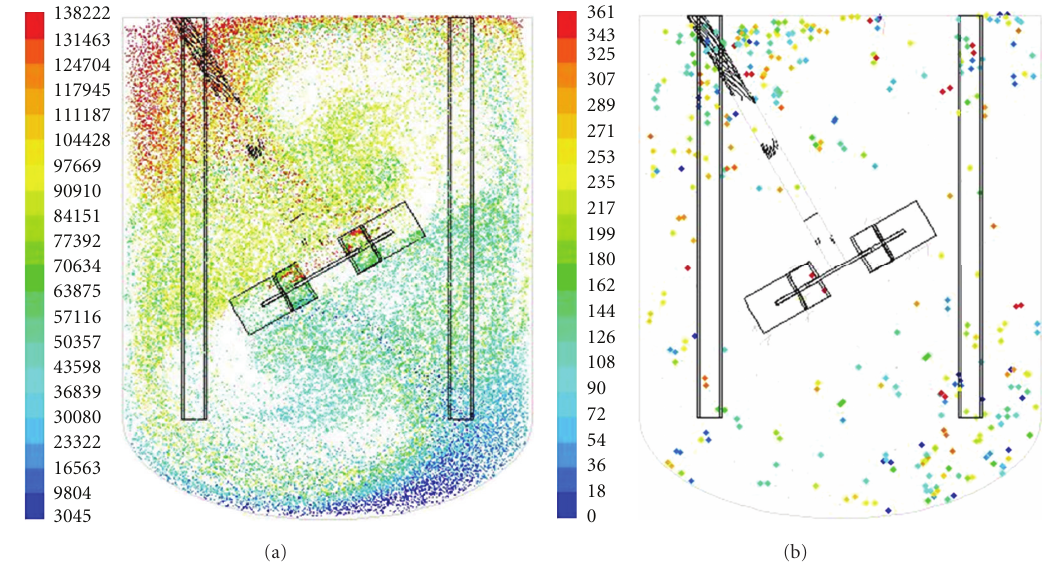
Figure 9: Simulation result of particle dispersion ( θ = 30 ◦